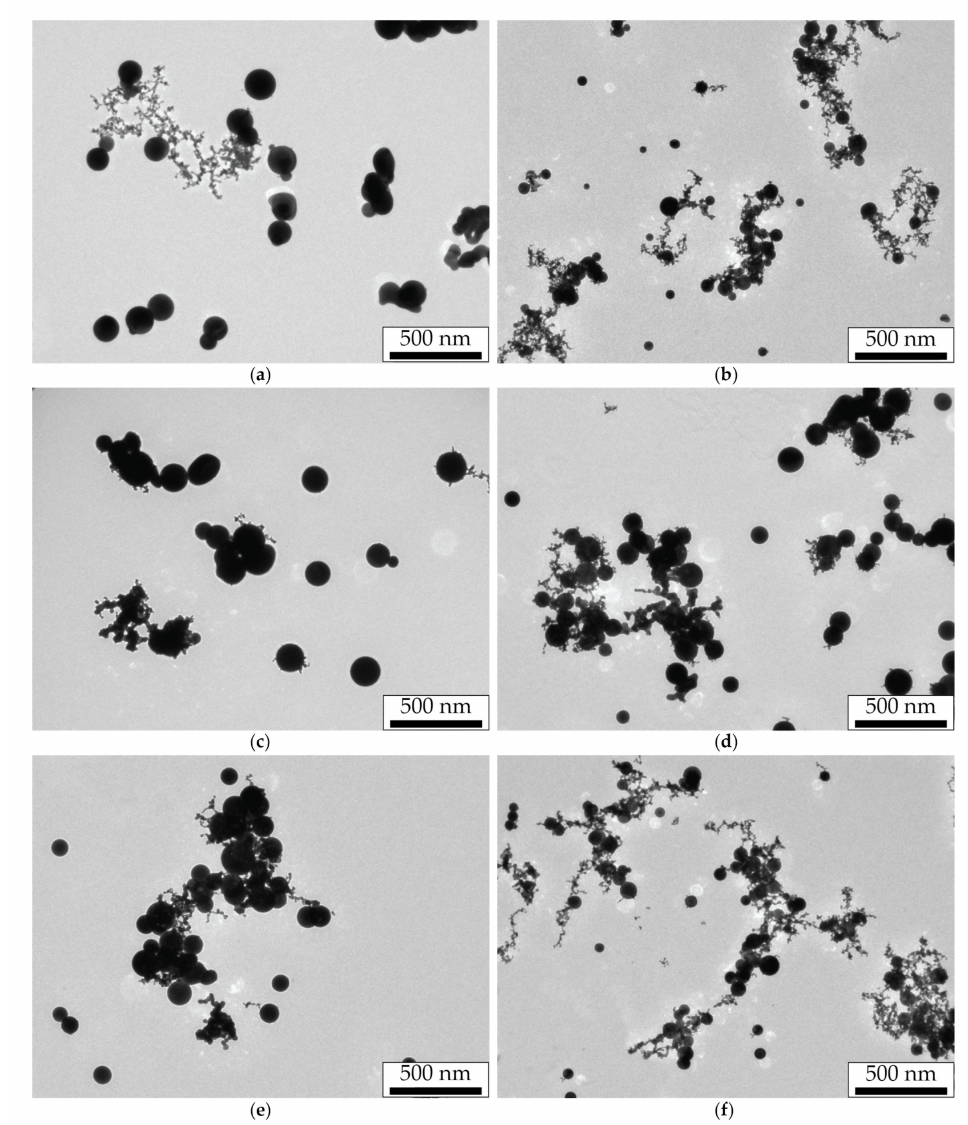
Figure 9. TEM images of gold NPs modified by laser radiation with the wavelength of 527 nm and the pulse repetition frequency of ( a , b ) 10 Hz and ( c – f ) 500 Hz at the pulse energy of 180 µ J and the aerosol flow rates of ( a , c ) 50, ( d ) 100, ( e ) 200, and ( b , f ) 400 mL/min. From the analysis of the series of TEM images, the average size of the modified NPs was 160, 100, 92, and 70 nm for the frequency of 500 Hz and the gas flow rates of 50, 100, 200, and 400 mL/min, respectively, and also 142 and 55 nm for the frequency of 10 Hz and the gas flow rates of 50 and 400 mL/min, respectively. The presented sizes of spherical NPs modified by green laser radiation turn out to be close to the sizes of NPs sintered by IR laser radiation. However, smaller particles adjacent to these spheres clearly indicate the incompleteness of the sintering processes in these regimes, which is the main difference. With an increase in the gas flow rate, the incompleteness of sintering becomes more obvious—longer and branched chains of smaller particles are observed around sintered spherical particles, and their appearance becomes more similar to the original dendrite-like agglomerates (Figure 2a,b). Moreover, images of NPs obtained by sintering at different pulse repetition frequencies for the gas flow rate of 50 mL/min differ more strongly than for the flow rate of 400